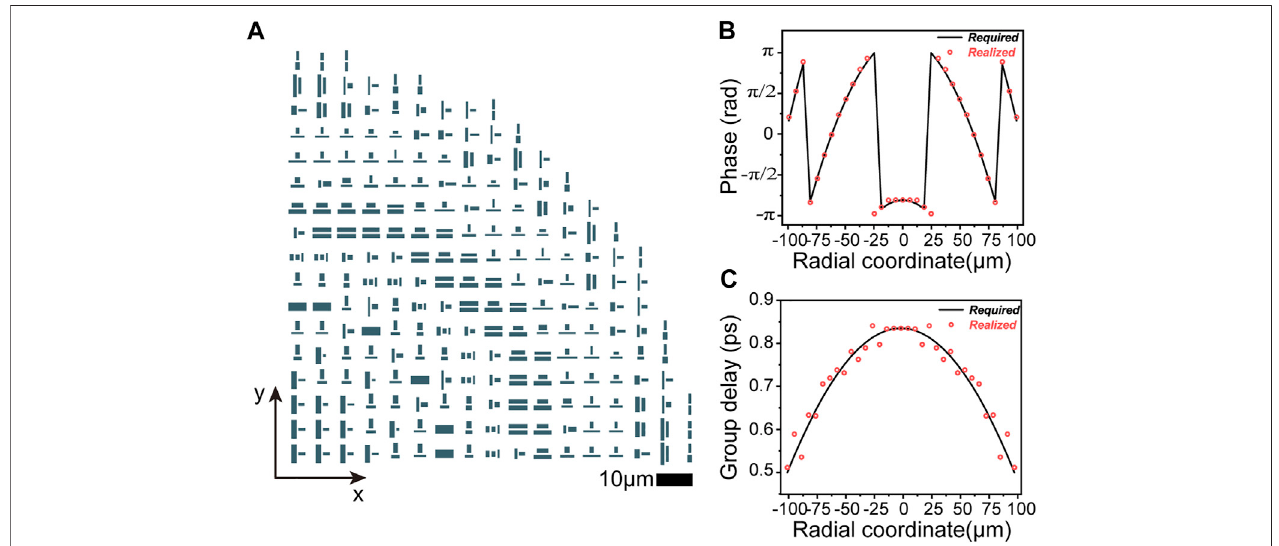
FIGURE3 | Design result ofthebroadband achromatic metalens. (A) Layout ofthequarterof themetalens. (B,C) Realized (redcircles) and required (black curves) phase and group delay at each radial coordinate on the metalens.